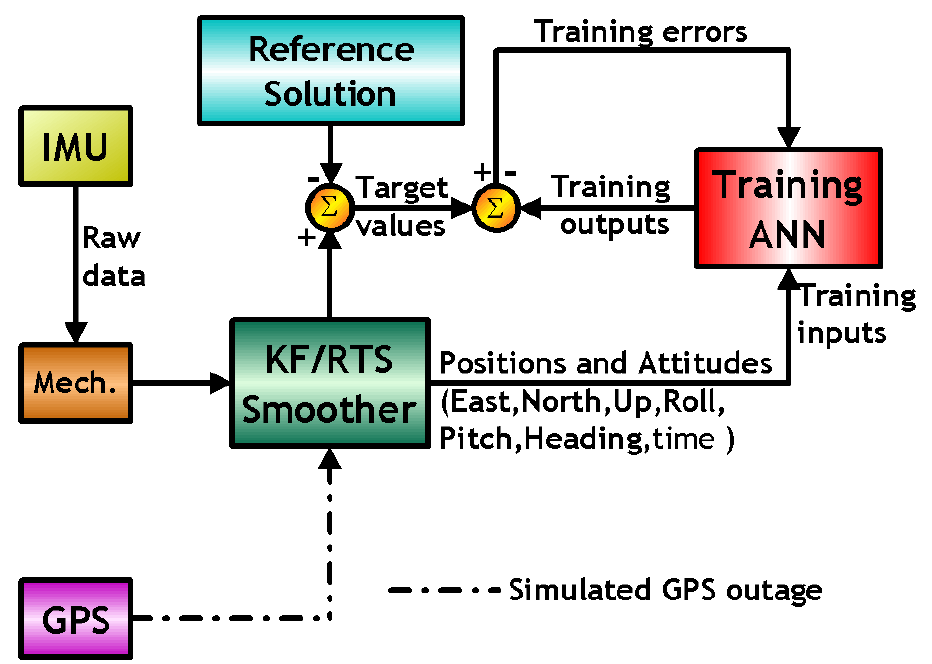
Figure 7. An ANN training